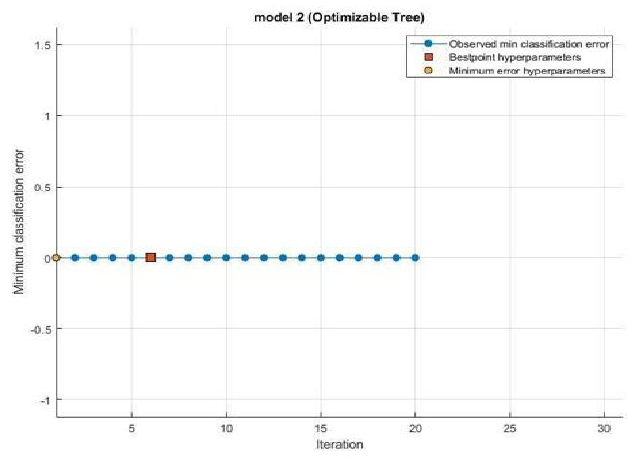
Fig. 19. SSDP flood minimum classification error of grid search based optimized tree